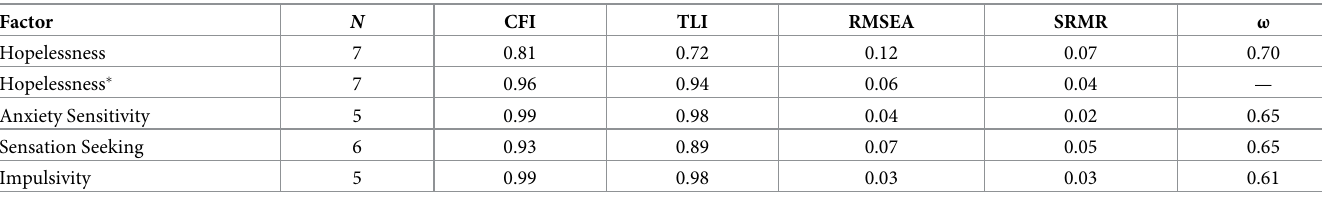
Table 2. Psychometric properties of personality